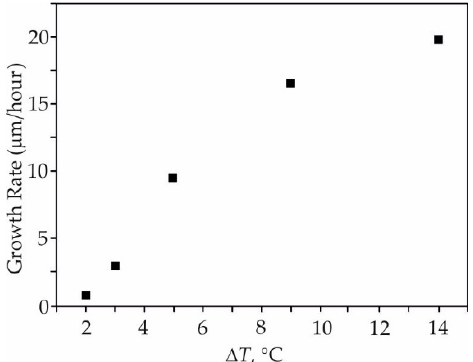
Figure 11. Nd:YAB crystal growth rate on rhombohedral face seed crystal vs. supercooling Δ T [45].